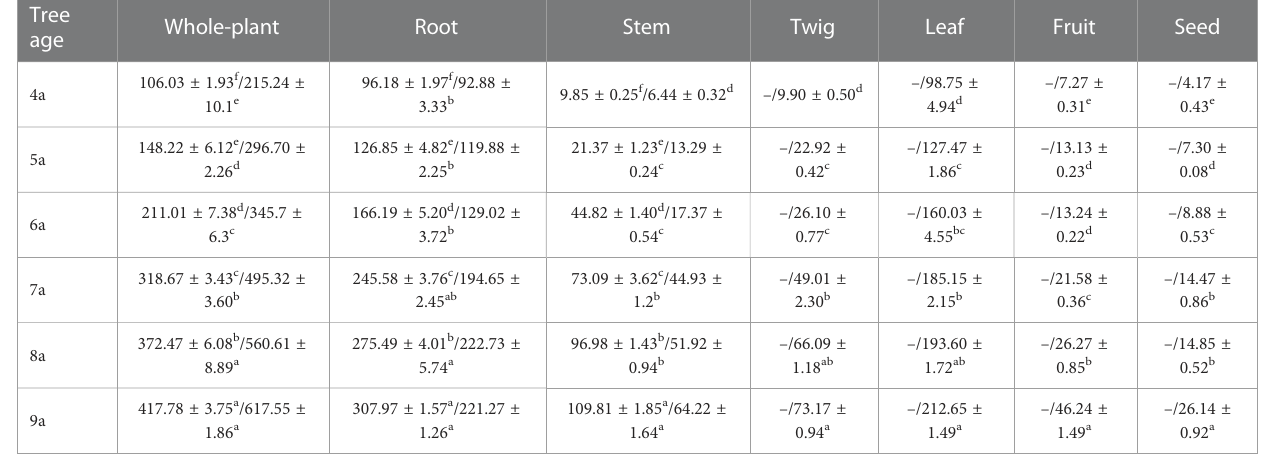
TABLE 2 Average values of biomass (± SD) (g) of each organ and whole-plant of Fengdan during dormancy/fruit ripening. Tree Whole-plant Stem Twig age